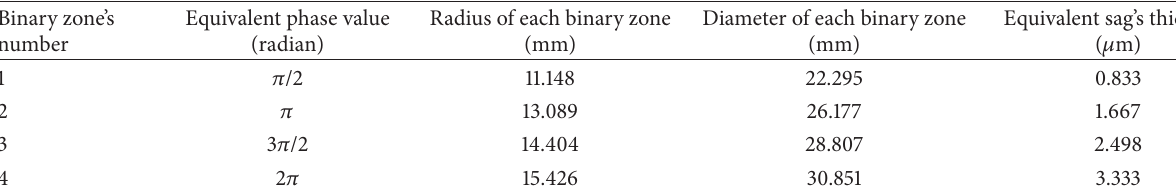
Table 3: Diameters and thickness of each binary zone.